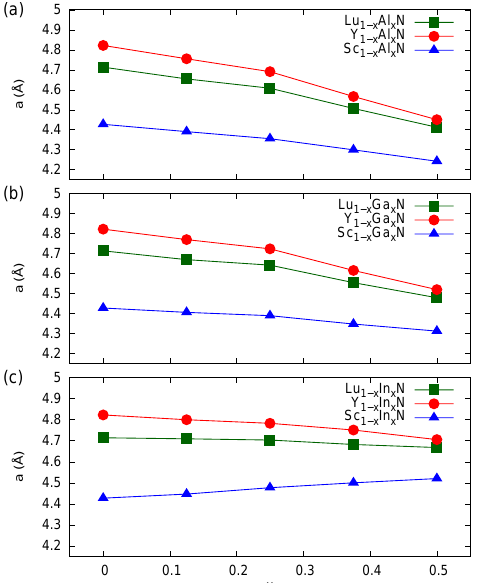
Figure 1. Cubic lattice parameters calculated (LDA) for rock salt alloys ( a ) RE 1 − x Al x N, ( b ) RE 1 − x Ga x N, ( c ) RE 1 − x In x N, where RE = Sc, Y, and